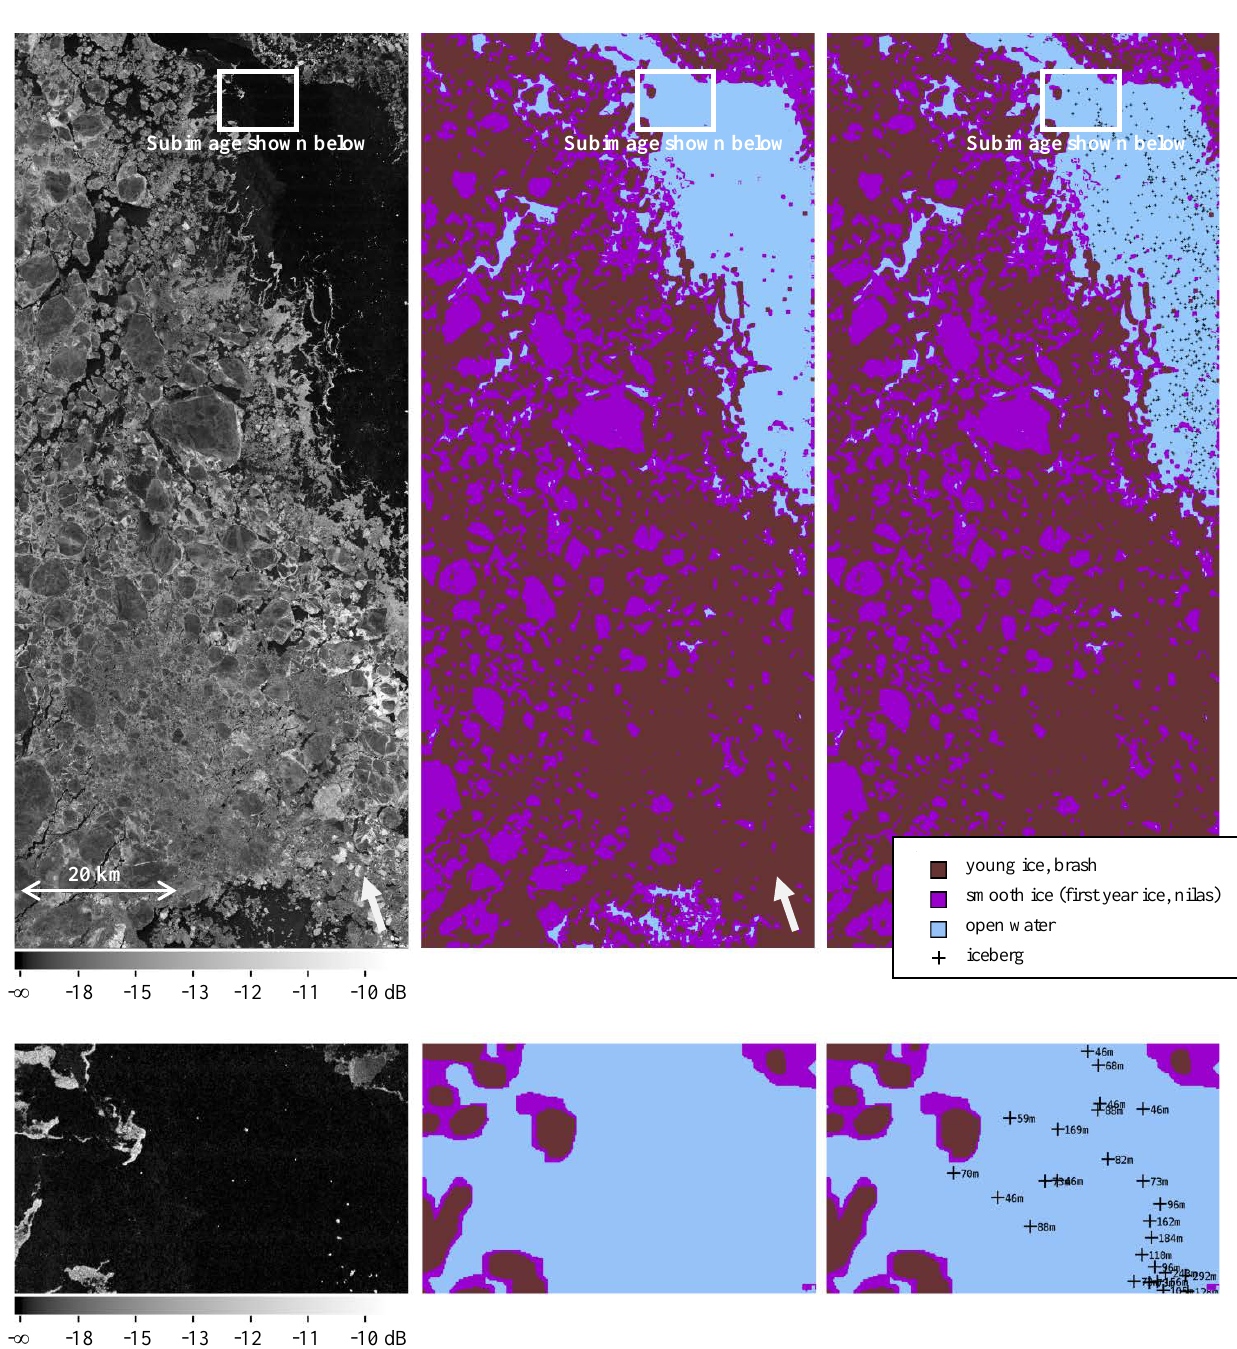
Figure 5. Section of a calibrated TerraSAR-X ScanSAR image taken on 2014/04/21 over Baffin Bay off the western Greenland coast (left, top row), corresponding output of the sea ice classification step (in the middle, top row) and output of the processor including iceberg positions and sizes (right, top row). Color coding for ice classification: blue: open water; brown: brash, young ice; purple: first year ice, nilas. White arrows indicate direction north. The white rectangle in the top row images delineates the location of zoomed subimages in the bottom